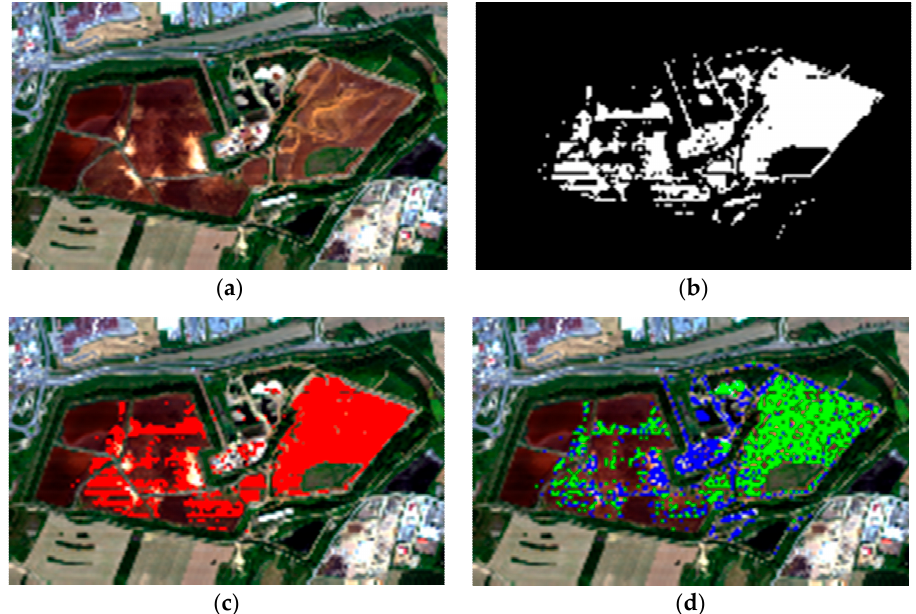
Figure 7. APEX VNIR color composite ( a ); and mask used for the area of interest ( b ). Map of red gypsum based on band positions in the VNIR ( c ). Map of red and white gypsum (green) and calcite (blue) based on band positions in the SWIR ( d ).